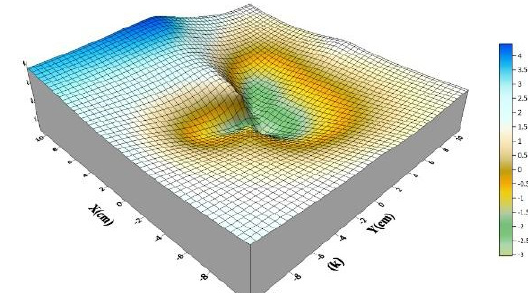
Fig. 8(o): The Scour and Deposition Pattern around Pier (P 2 ) at angle 19 0 and flowrate 18L/Sec. The green area denotes maximum scouring